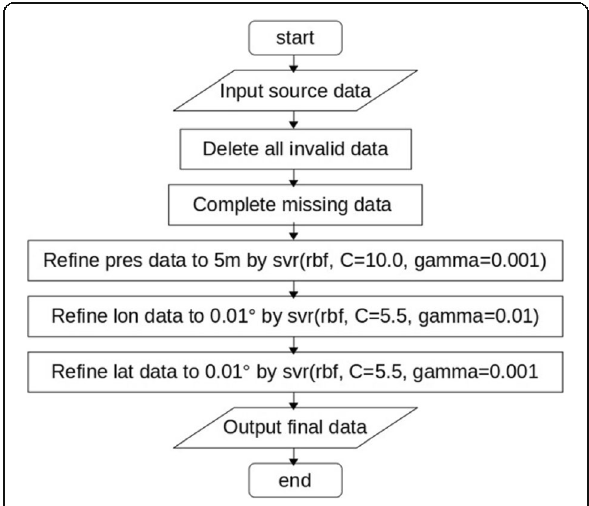
Fig. 3 The flow diagram of high-resolution data refinement